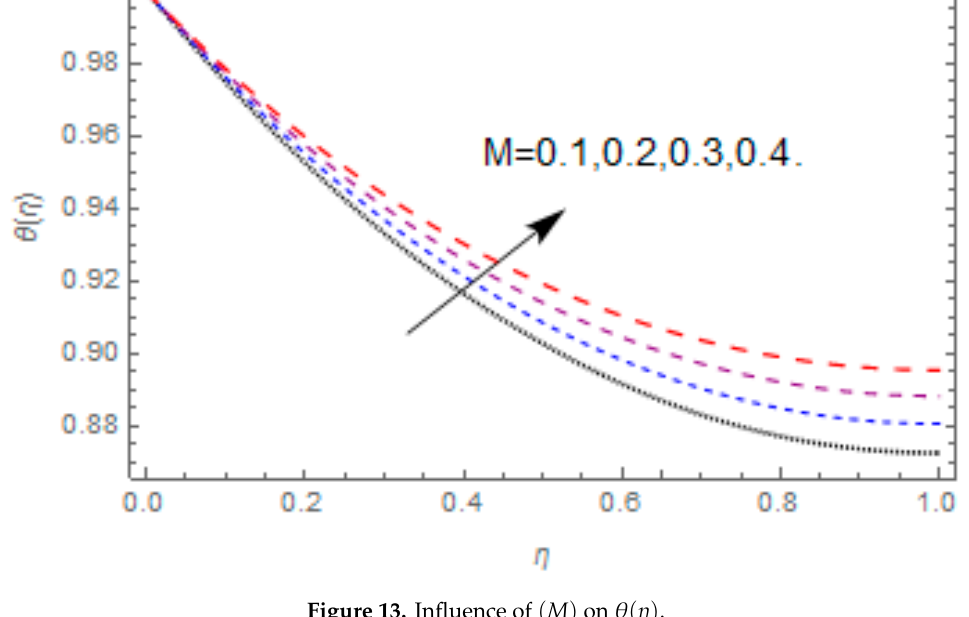
Figure 13. Influence of ( ) M on ( )